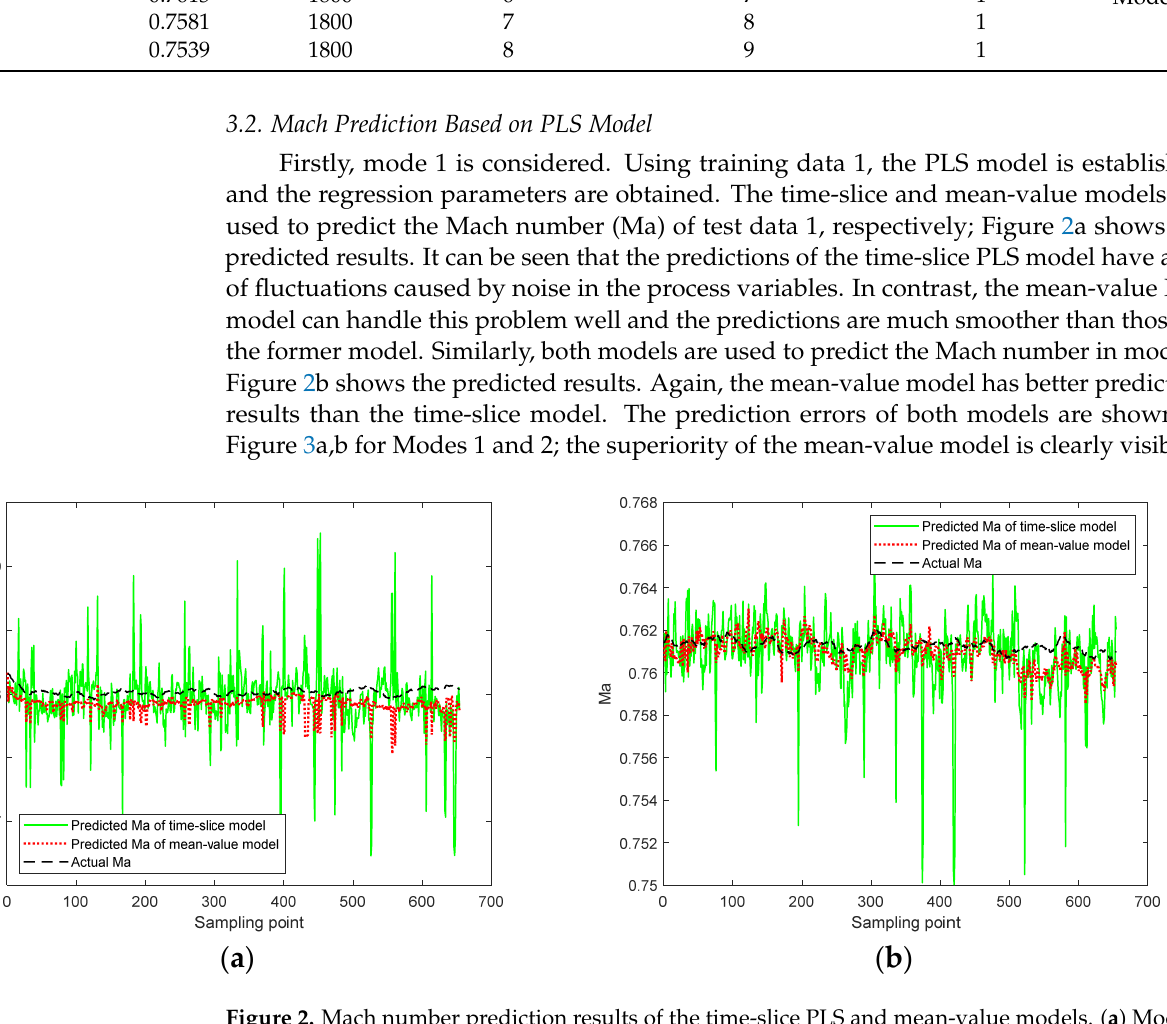
Figure 2. Mach number prediction results of the time-slice PLS and mean-value models. ( a ) Mode 1. ( b ) Mode 2.